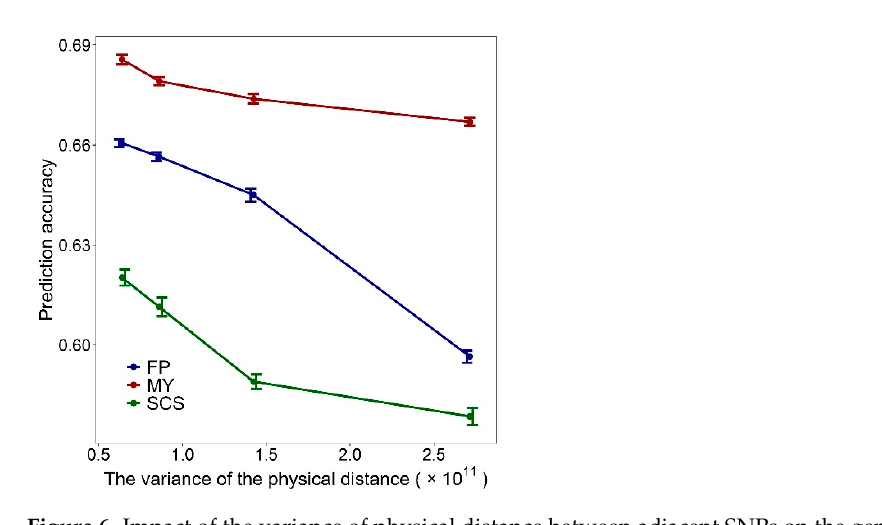
Figure 6. Impact of the variance of physical distance between adjacent SNPs on the genomic predic- tion accuracy, the standard errors of the genomic prediction accuracy is indicated by the whiskers.